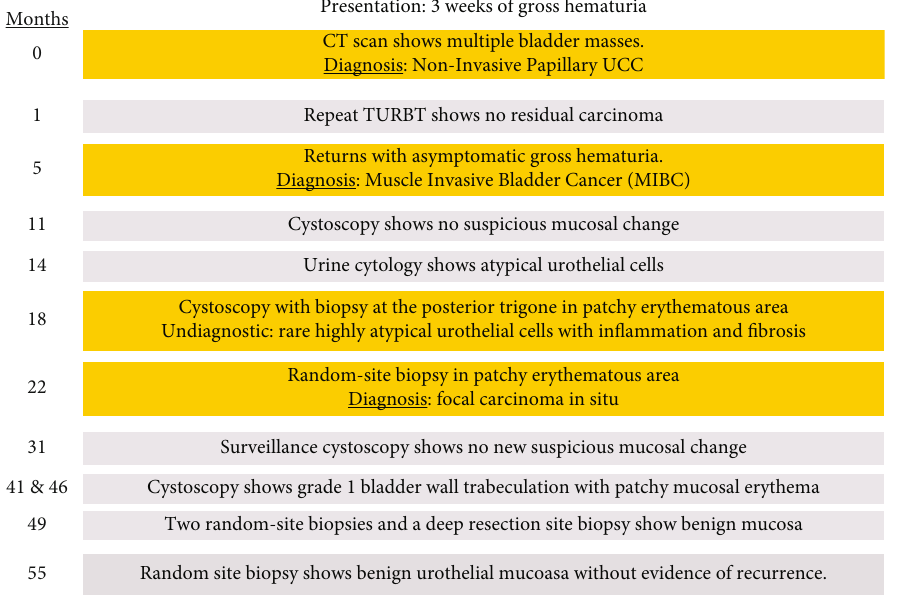
Figure 2: Chronologic timeline from presentation to 4 years status post muscle invasive bladder cancer